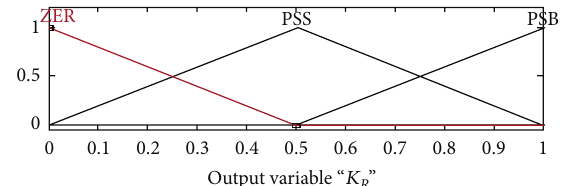
Figure 11: Membership function of fuzzy logic controller for output regulation gain ( 𝐹𝐾 𝑅 ).